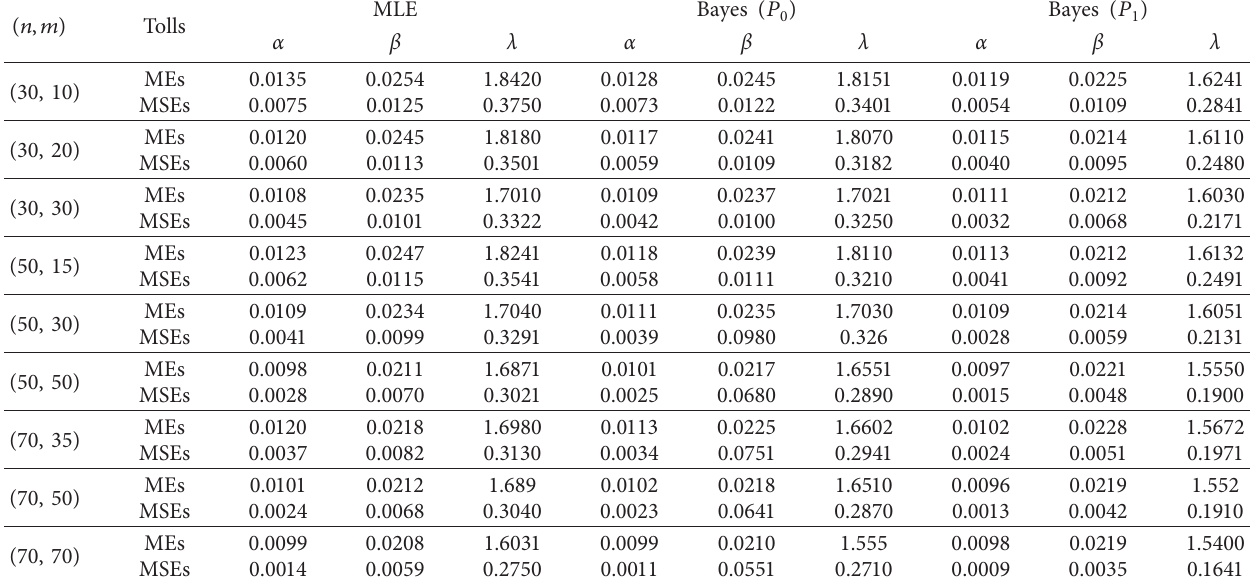
Table 4: MEs and MSEs from ω � 0 . 01 , 0 . 02 , 1 . 5 { } .